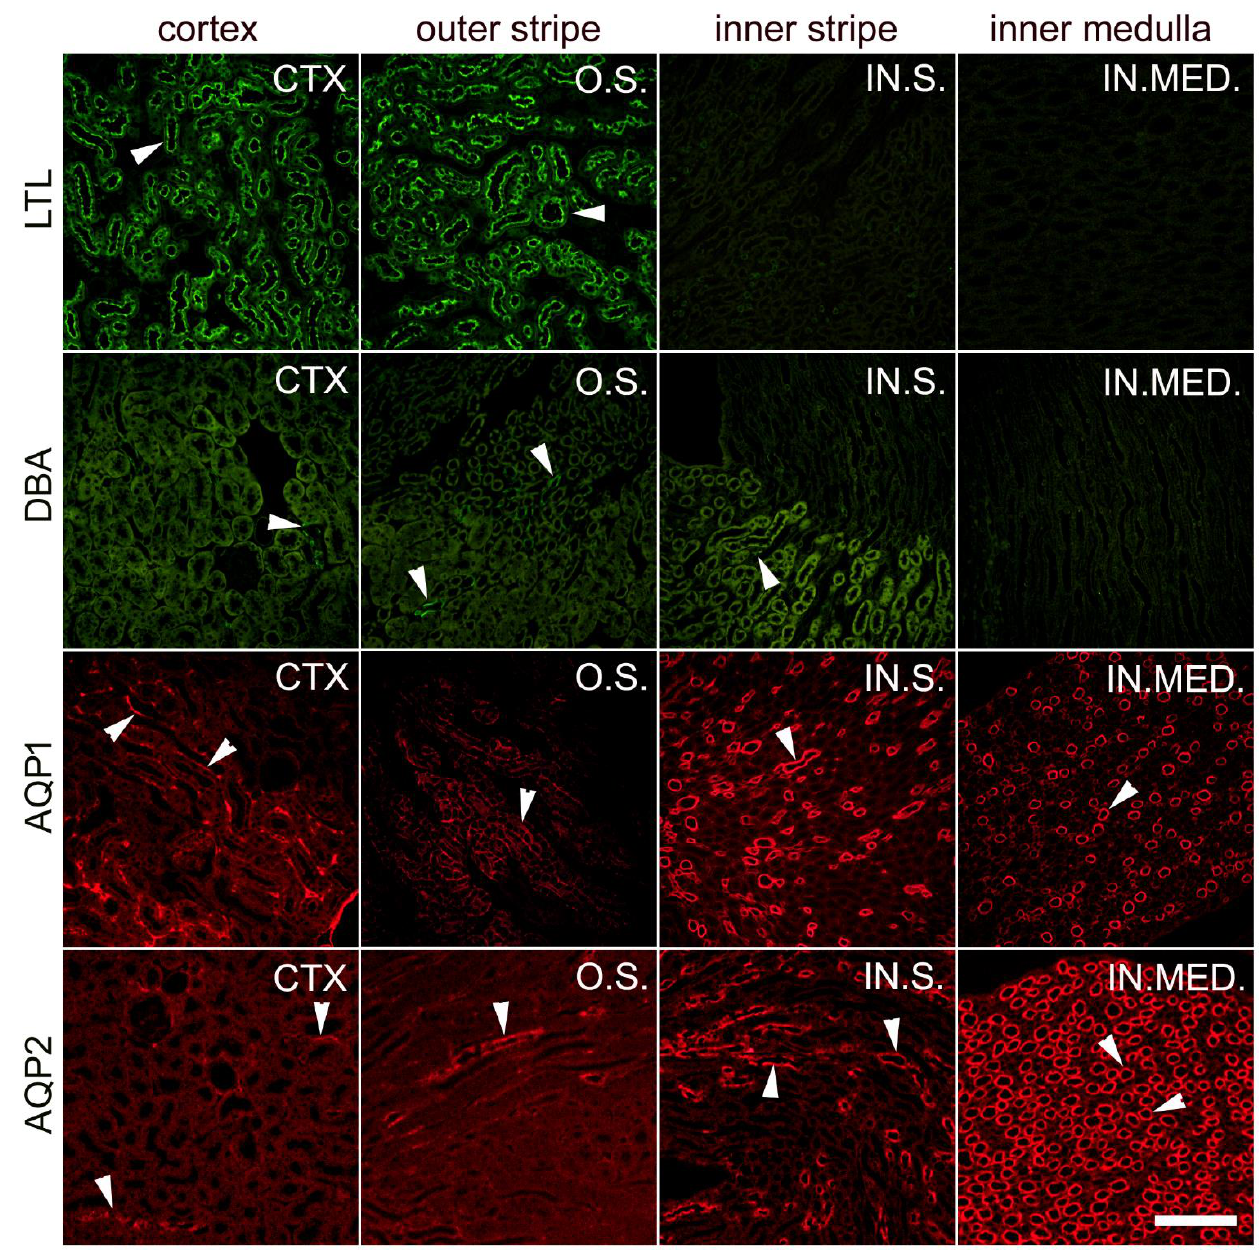
Figure 1. Distribution of tubular segment markers in different parts of the mice kidney. CTX.—cortex; O.S.—outer stripe of outer medulla; IN.S.—inner stripe of outer medulla; IN.MED.—inner medulla. Binding of Lotus tetragonolobus lectin (LTL) was specific to proximal tubules located in the cortex and outer stripe of the outer medulla (green; first row). Binding of Dolichos biflorus agglutinin (DBA) was found specifically in the distal tubules located in the cortex and in the outer and inner strips of the outer medulla (green; second row). The antibody against aquaporin 1 (AQP1) stained the proximal tubules in the cortex and outer stripe and the thin descending loop of Henle in the inner stripe and inner medulla (red; third row), whereas anti-aquaporin 2 (AQP2) stained various segments of the collecting ducts in the cortex, outer medulla, and inner medulla (red; fourth row). Scale-bar = 40 µm, refers to all (magnification 200×).